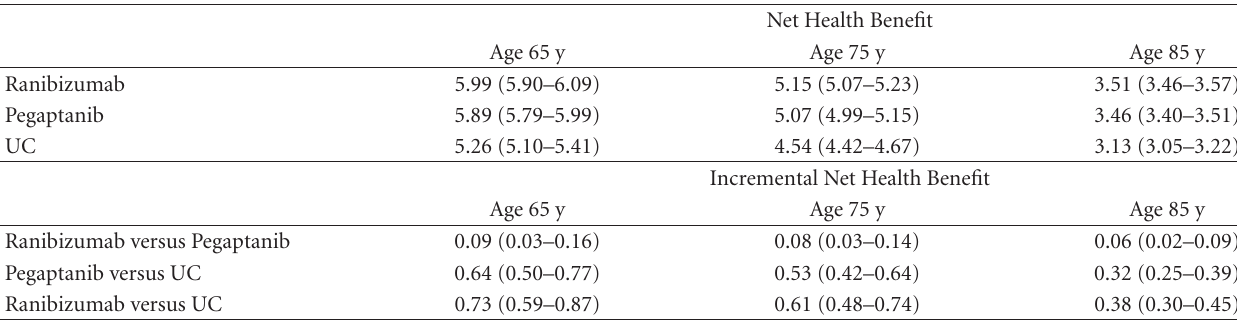
Table 5: Net health benefits, and incremental net health benefits, in quality-adjusted life years, of VEGF inhibitor treatment in NV-AMD patients, incorporating utility values based on ETDRS visual acuity categories.